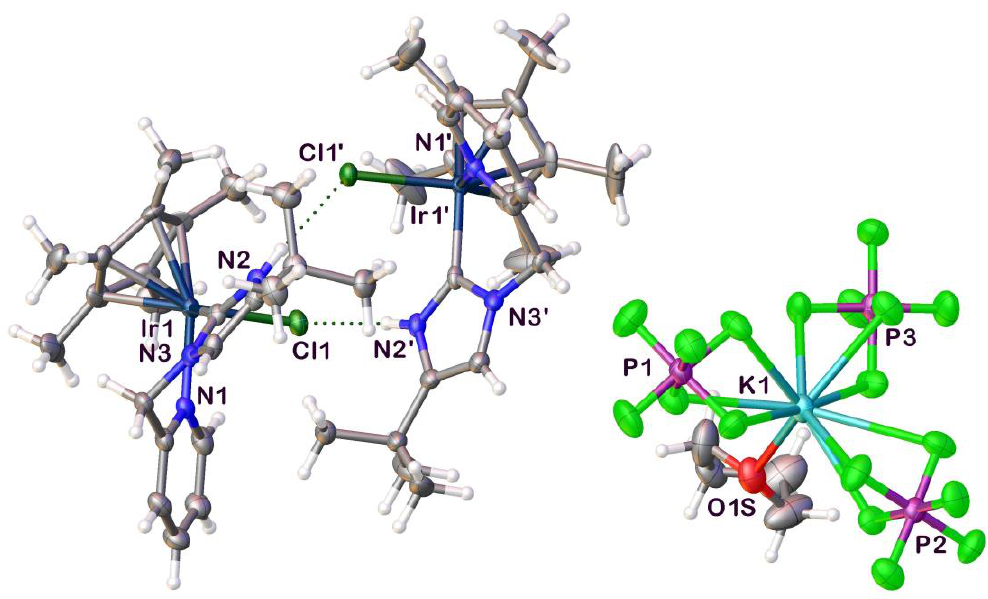
Figure 1. Crystal structure of ( 9b-Ir)KPF 6 · 1.5THF isolated using KPF 6 as described in the text. One THF molecule is excluded for clarity. The graphic shows bonds between K + and three PF 6 − ions but the structure should be regarded as ionic.